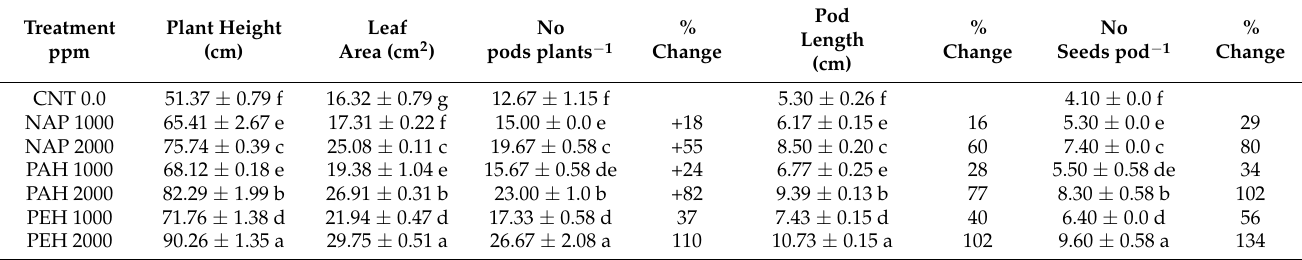
Mean values in the same column for each trait followed by the same lower-case italic letter is not significantly different according to Duncan’s multiple range test at p ≤ 0.05.